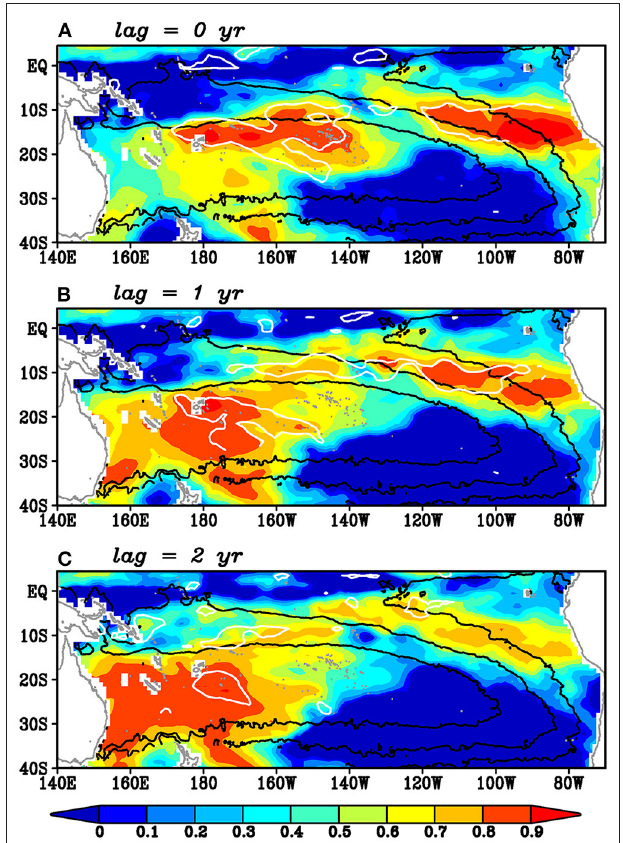
FIGURE 9 | Lag correlation coefficients of the low-pass filtered salinity on the 25–25.5 σ θ isopycnals onto the low-pass filtered salinity anomalies on the 25–25.5 σ θ isopycnals averaged over the upstream region (12.5 ◦ -17.5 ◦ S, 90 ◦ -100 ◦ W; red thick line in Figure 4 ) for the lag years of (A) 0, (B) 1, and (C) 2, where positive lag means that the salinity in the upstream region leads. White contours denote the regions where the correlations are significant at 90% confidence level. Black contours denote 6,000, 7,000, and 8,000kg m − 1 s − 2 isopleths of the mean Montgomery potential.